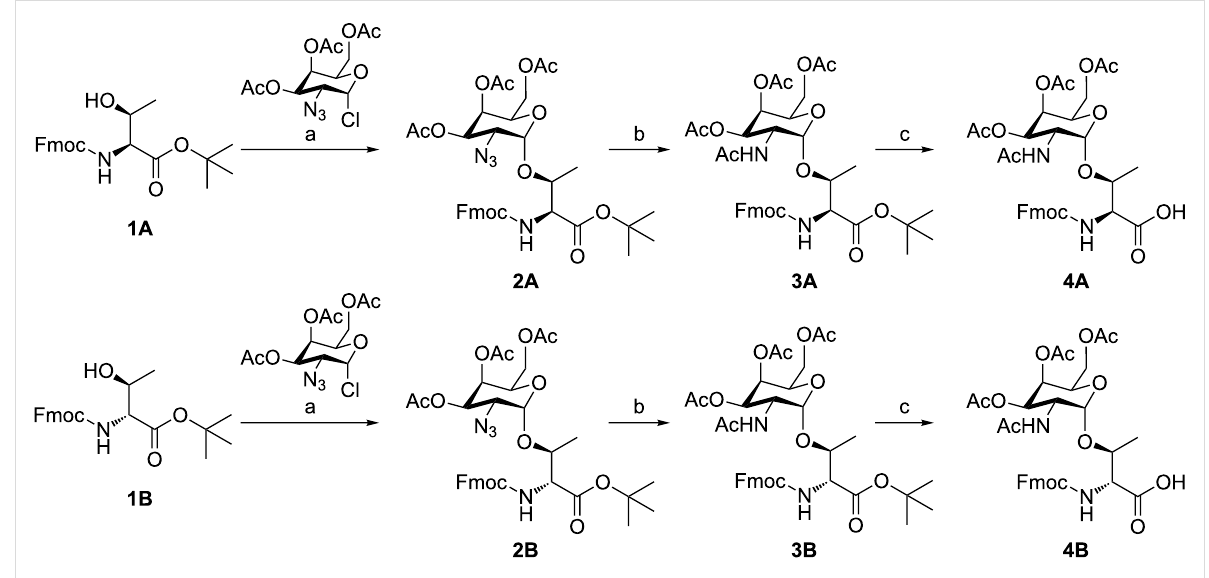
Scheme 1: Synthesis of the monosaccharide-substituted threonine building block ( A = allo -L-threonine; B = D-threonine). (a) Ag 2 CO 3 , AgClO 4 , CH